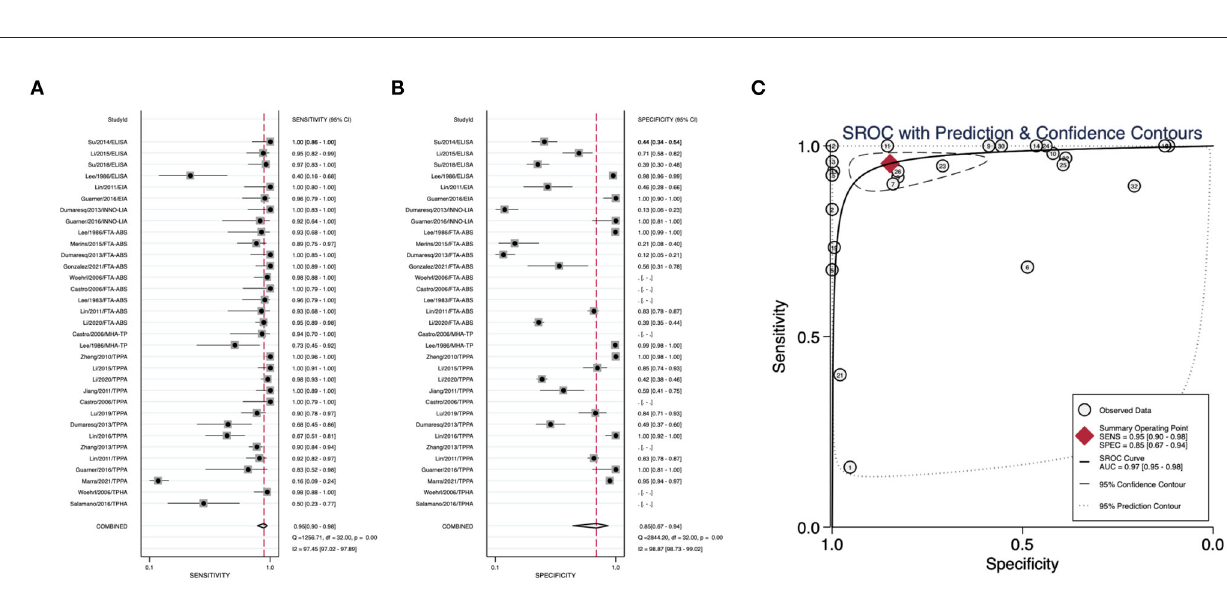
FIGURE3 Pooled sensitivity, pooled specificity, and summary ROC curve of treponemal tests. (A) Forest plots of pooled sensitivity. (B) Forest plots of pooled specificity. (C) Summary ROC curve and its area under the